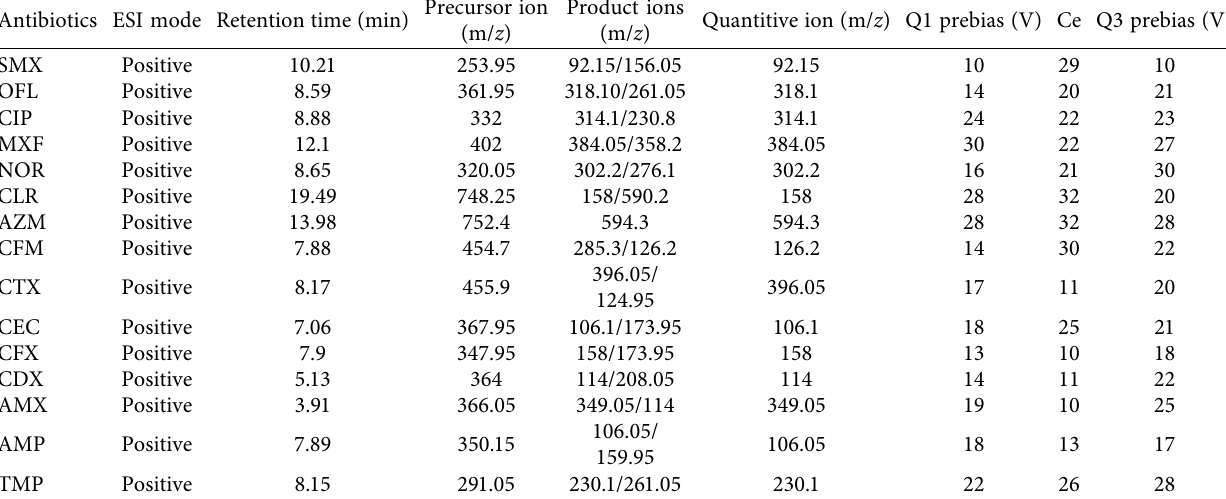
Table 1: Optimized UPLC-ESI-MS/MS parameters for selected antibiotics.